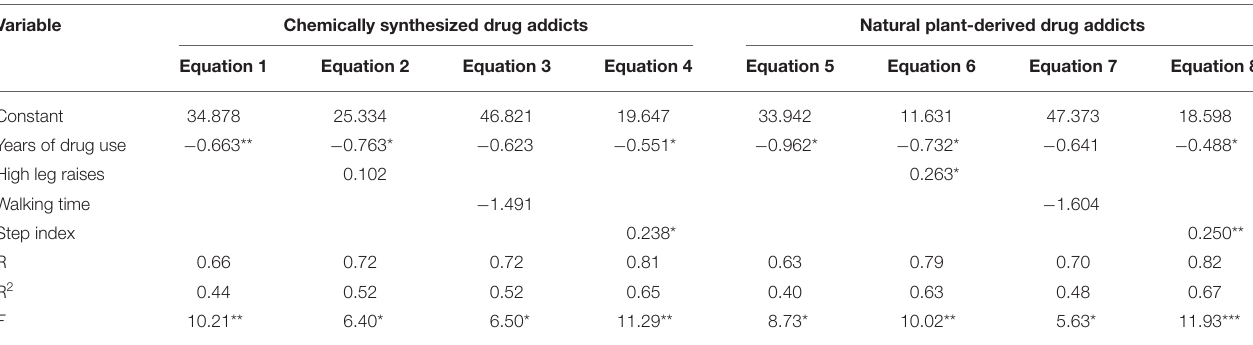
TABLE 5 | Stepwise regression of different methods to estimate VO 2max ( n =